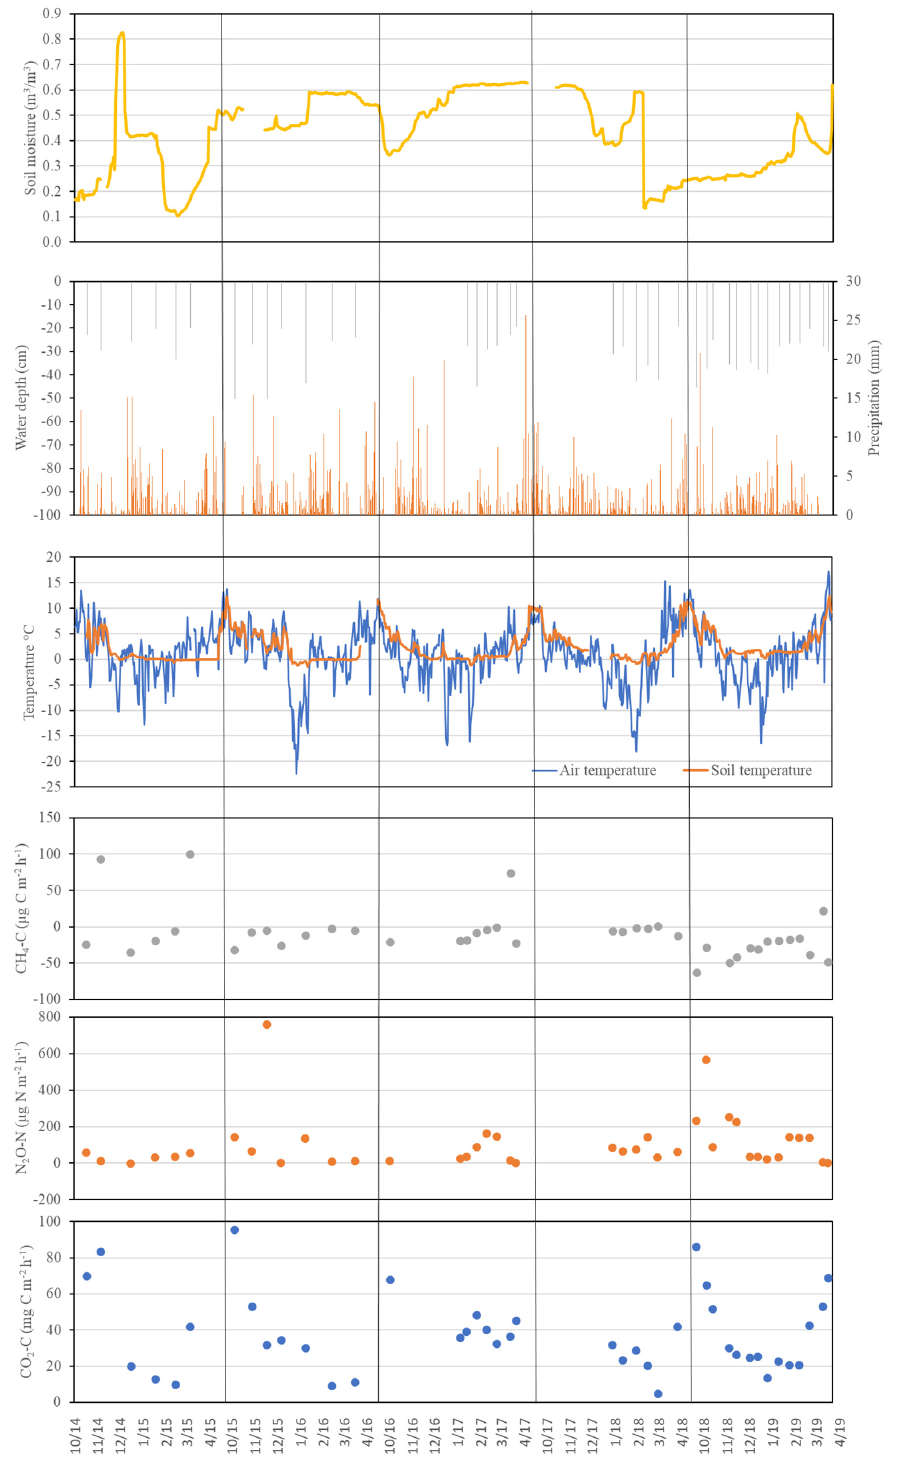
Figure A1. Temporal dynamics of key environmental parameters and greenhouse gas emissions in the Downy birch forest (DB).